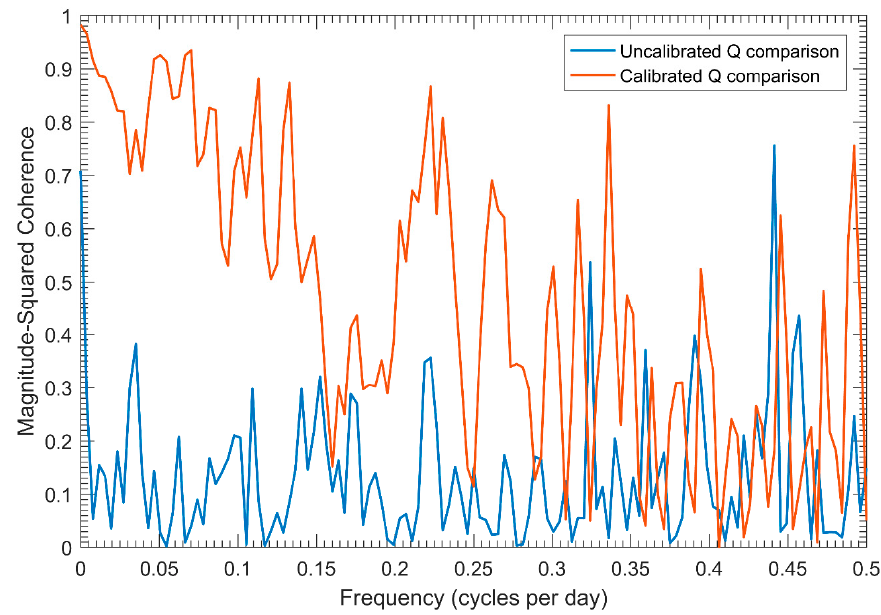
Figure 6. Magnitude squared coherence via Welch comparing measured streamflow with uncalibrated and calibrated streamflow. A value of 1 indicates the frequency is present in both the measured and predicted signals and a zero means it was present in one and not the other.